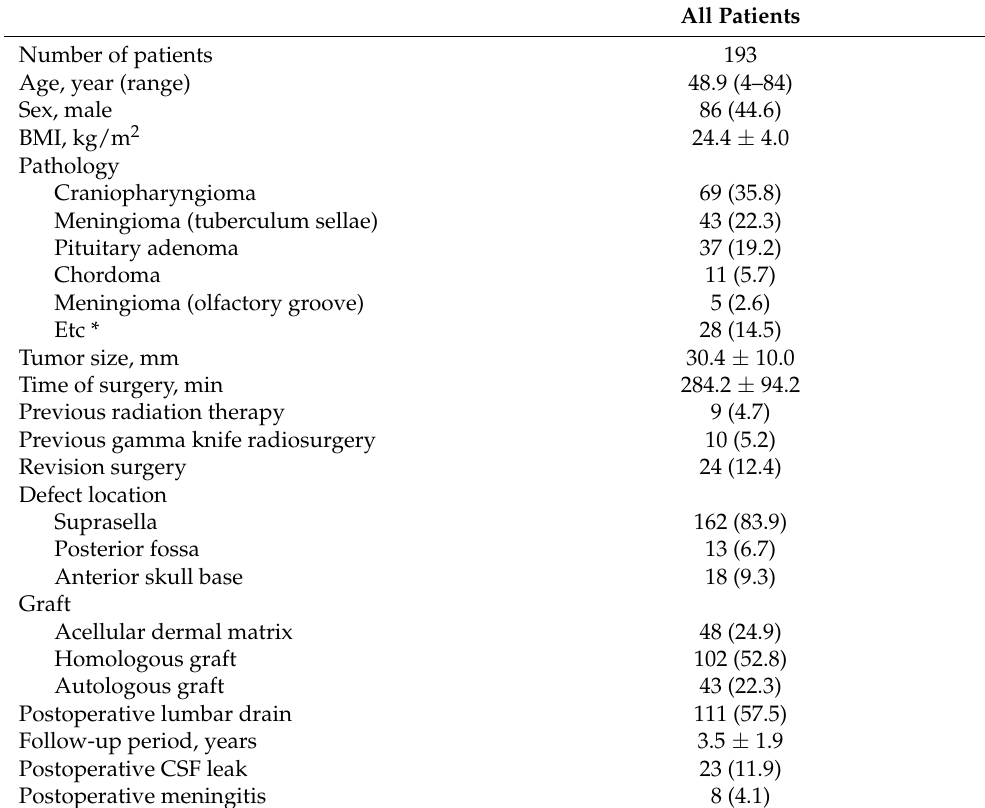
Table 1. Baseline